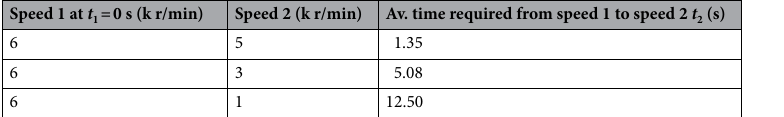
Table 4. Measured results of a speed change in the